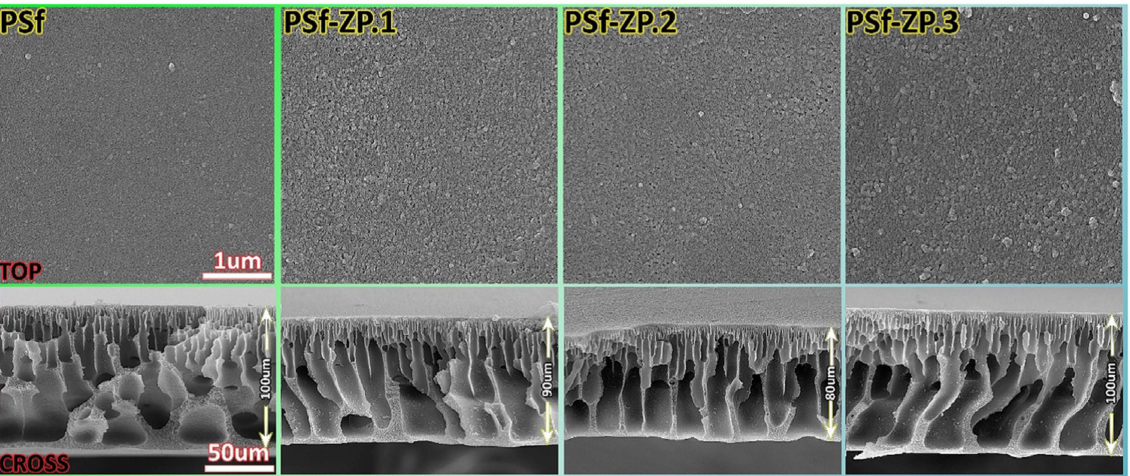
Figure 7. Scanning electron microscopy (SEM) pictures of the cross-section and top surface of support layers with various ZnO@PMMA loading (0, 0.125, 0.25, and 0.5 wt.%) Reproduced from reference [83] with permission from Elsevier